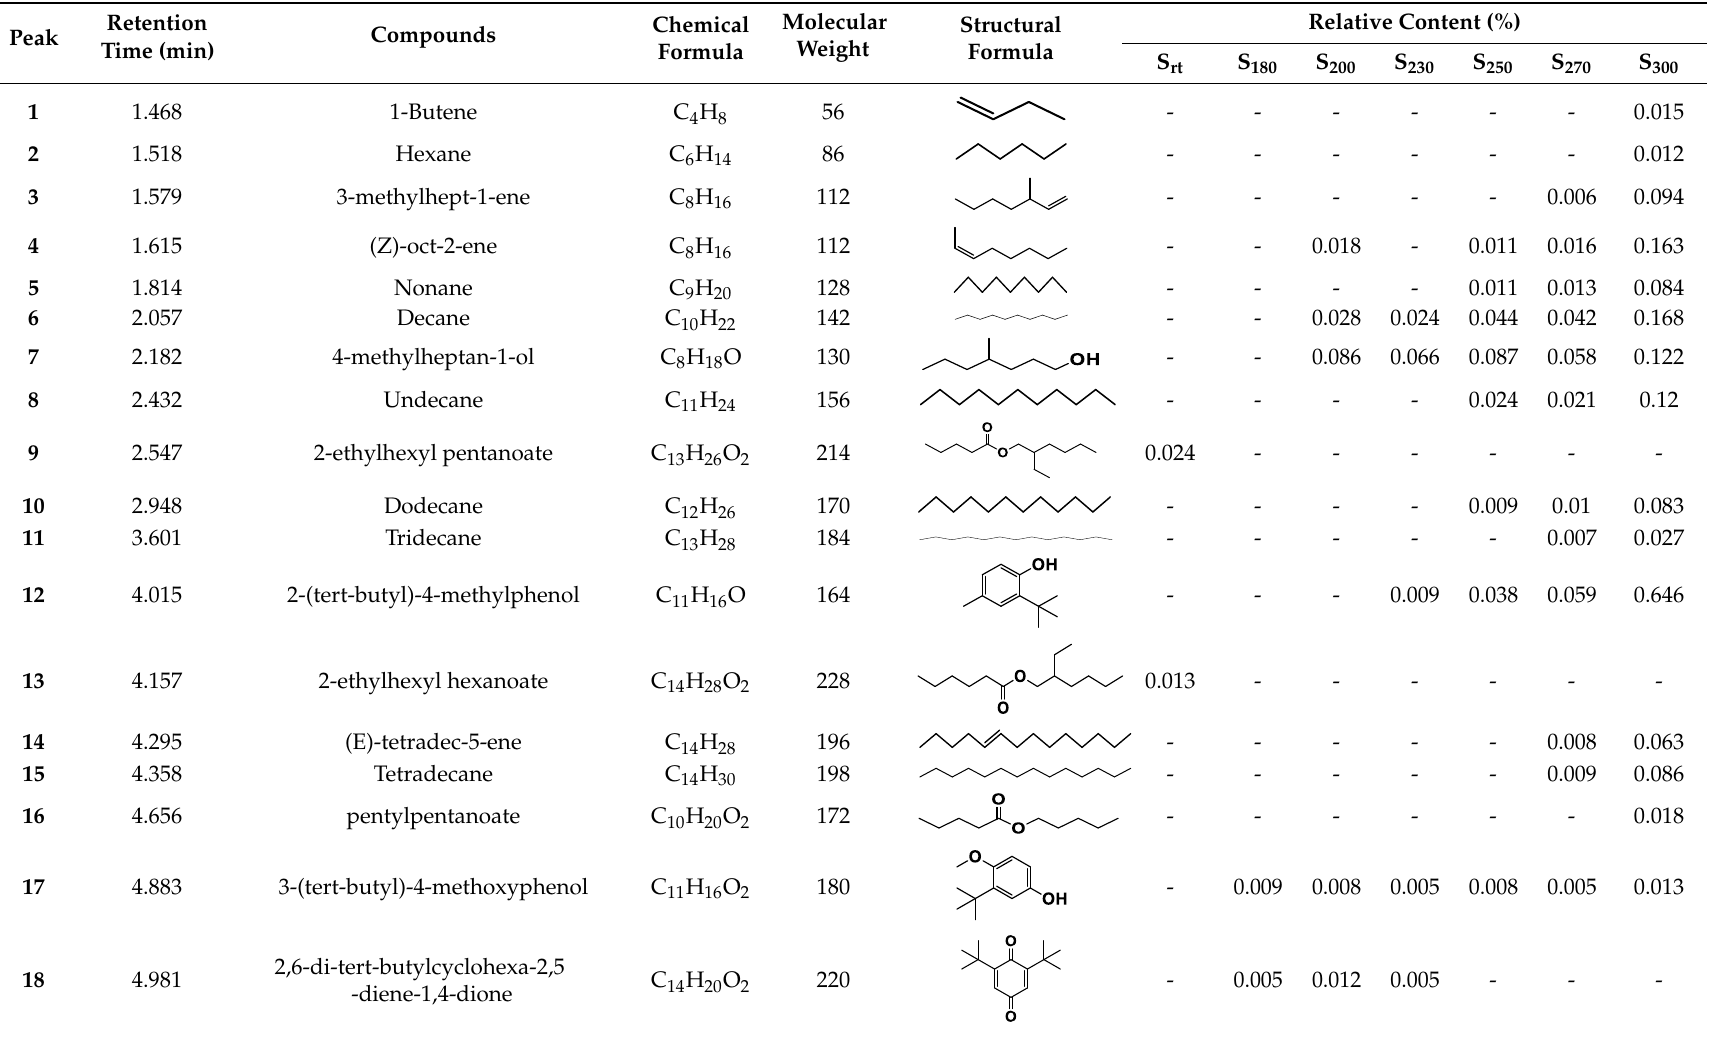
Table 2. Compounds detected in the total ion chromatograms of the oil samples as a function of temperature at retention times of 1 – 11 min. Peak